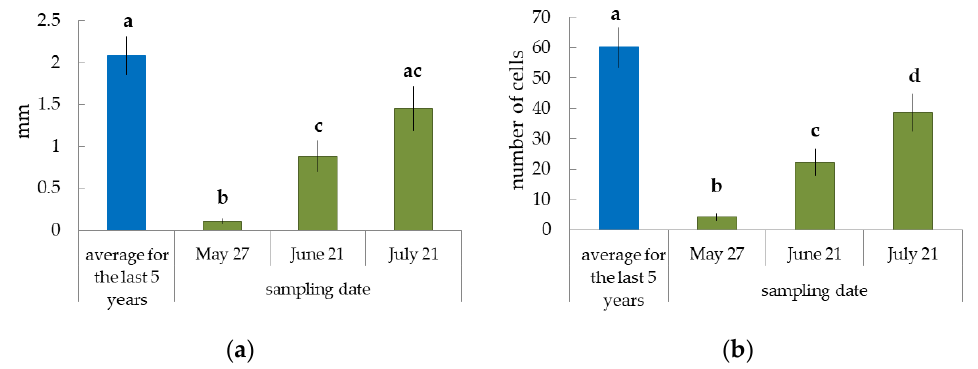
Figure 6. The width of annual xylem increment ( a ) and number of cells in the radial raw of the xylem ( b ) in 40-year-old pine trees. The blue color—the average meanings for the last 5 years, 2017–2021 (samples were collected in May 2022) and the green color—the meanings of current year xylem (Samples collected in May–July 2022). Different letters show significant differences at p -value ˂ 0.05.